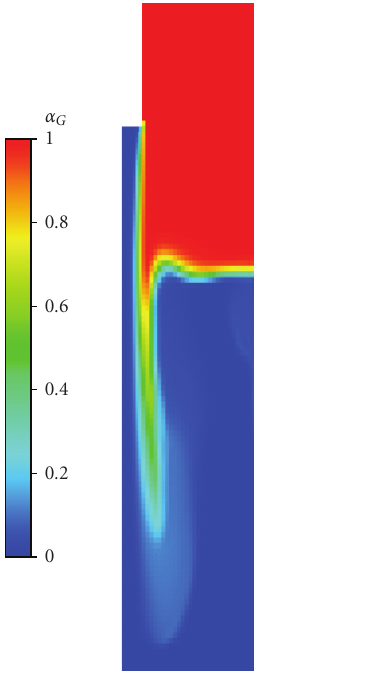
Figure 14: Gas void fraction α G for the free surface drag coe ffi cient C D = 10.